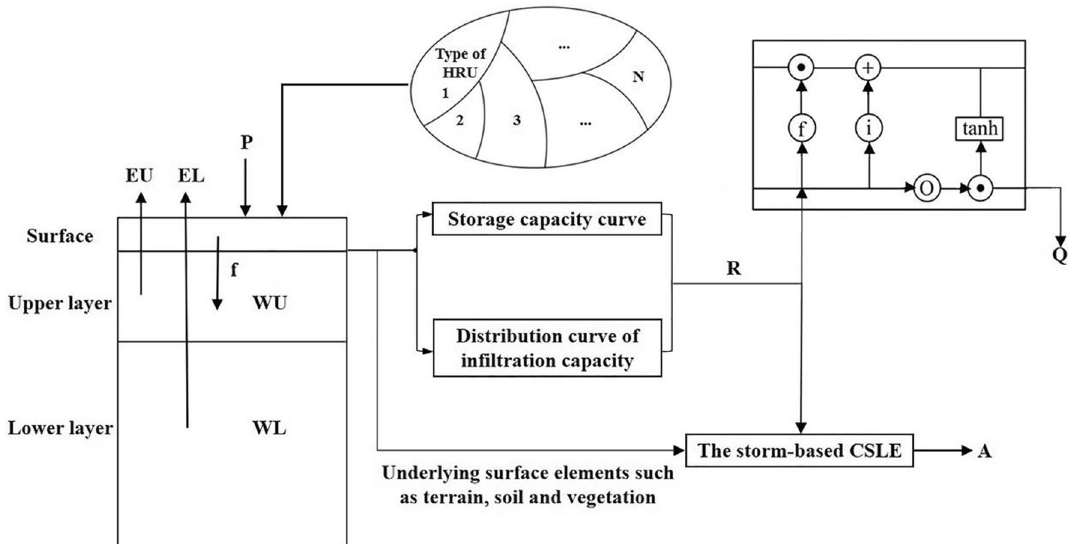
Fig. 2 Model structure diagram